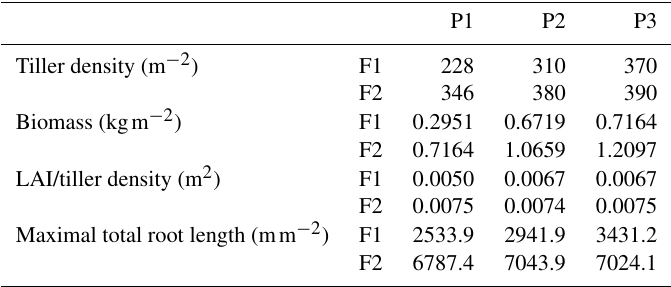
Table 3. Tiller density (measured on 11 Jun 2014), crop biomass (including straw and grain, which were measured after the harvest), ratio of leaf area index (LAI) to tiller density, and maximal root length in the three plots (P1: sheltered; P2: rainfed; P3: irrigated) of the stony (F1) and silty (F2)